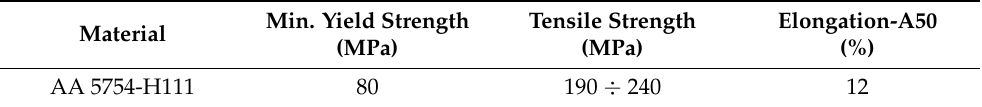
Table 2. Mechanical properties of the AA 5754-H111 aluminium alloy used, according to the mate- rial